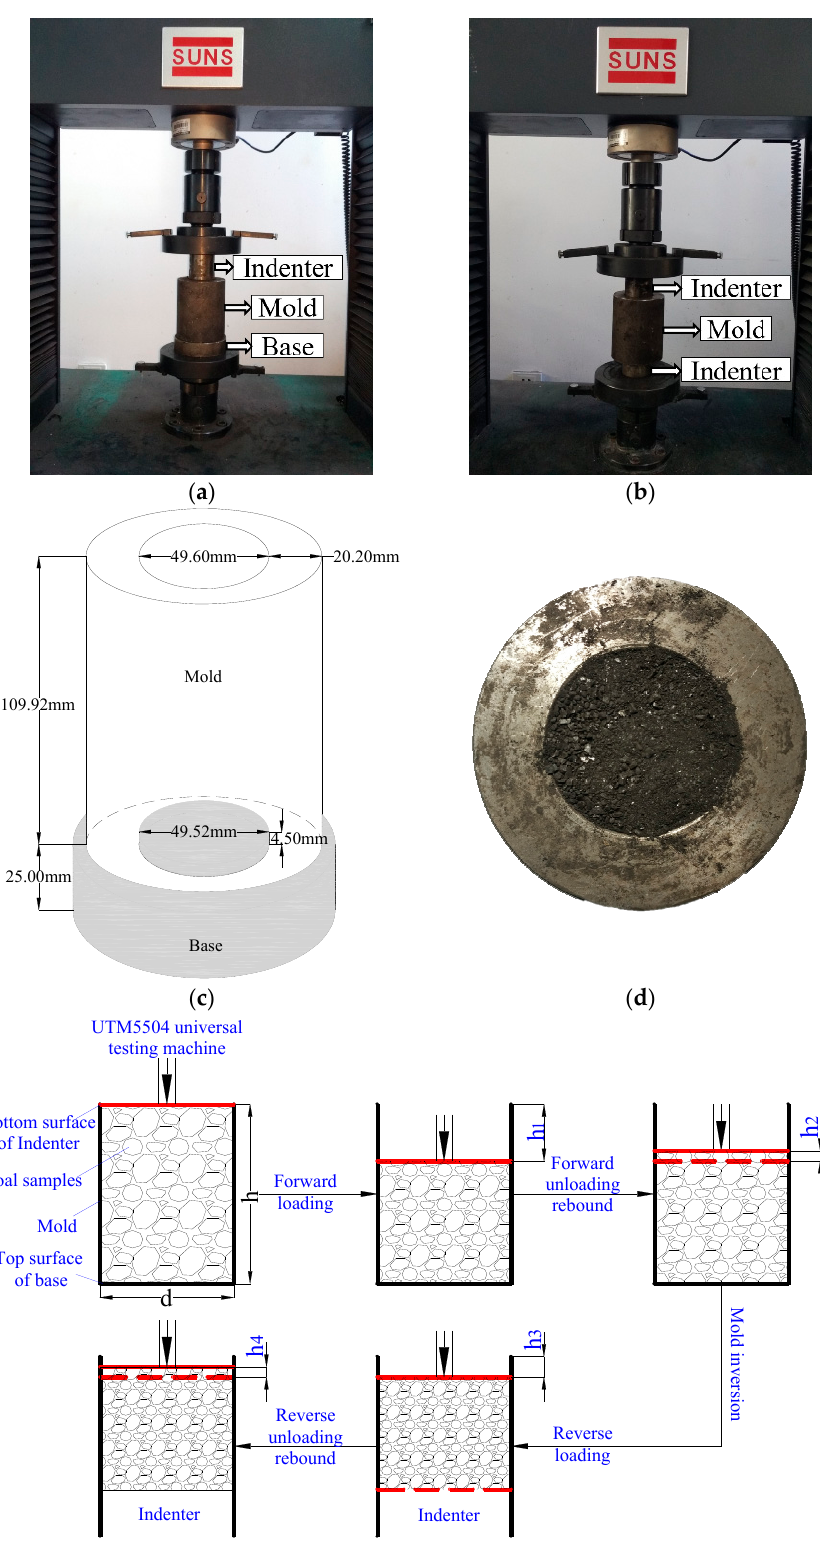
Figure 6. ( a ) Forward loading photograph; ( b ) reverse loading photograph; ( c ) mold schematic diagram; ( d ) schematic diagram of initial experimental coal samples; and ( e ) schematic diagram of the test apparatus and methodology for determining bulk density of coal at different pressures.